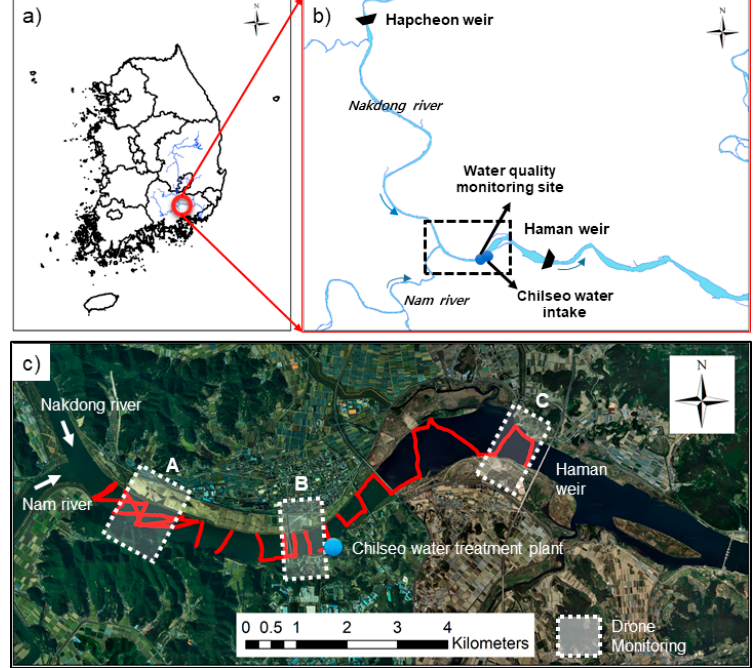
Figure 1. The study area of downstream vicinity of the Nam and Nakdong river confluence where three months of ADCP and UAV measurements were carried out simultaneously: ( a ) the location of the study area in southeastern South Korea; ( b ) the study area, in the black dashed line box, and the locations of the water quality monitoring site operated by the government, Chilseo water intake, and Haman weir, recently installed as part of the four major rivers project at the top of the planform with the confluence; and ( c ) locations of the ADCP measurements (red dots) before algal bloom development and aerial monitoring with a UAV (white dots) during mid-point of algal bloom development during the subsequent three months with similar streamflow conditions.